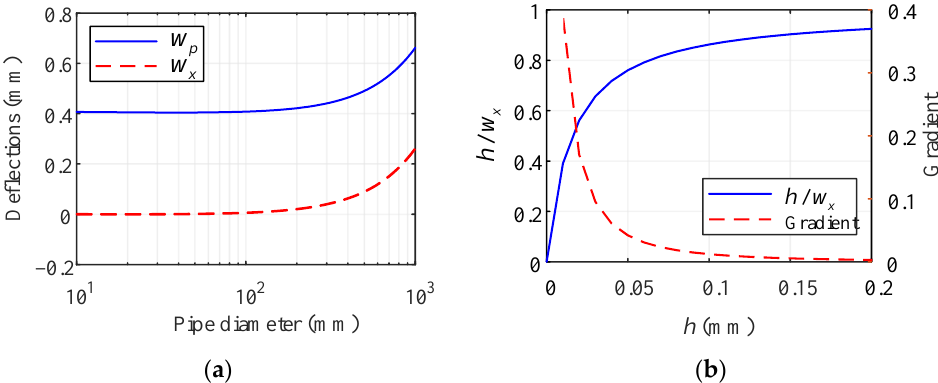
Figure 12. ( a ) Deflections as a function of pipe diameter and ( b ) ratio h / w x as a function of radial clearance, h , at x = 0.